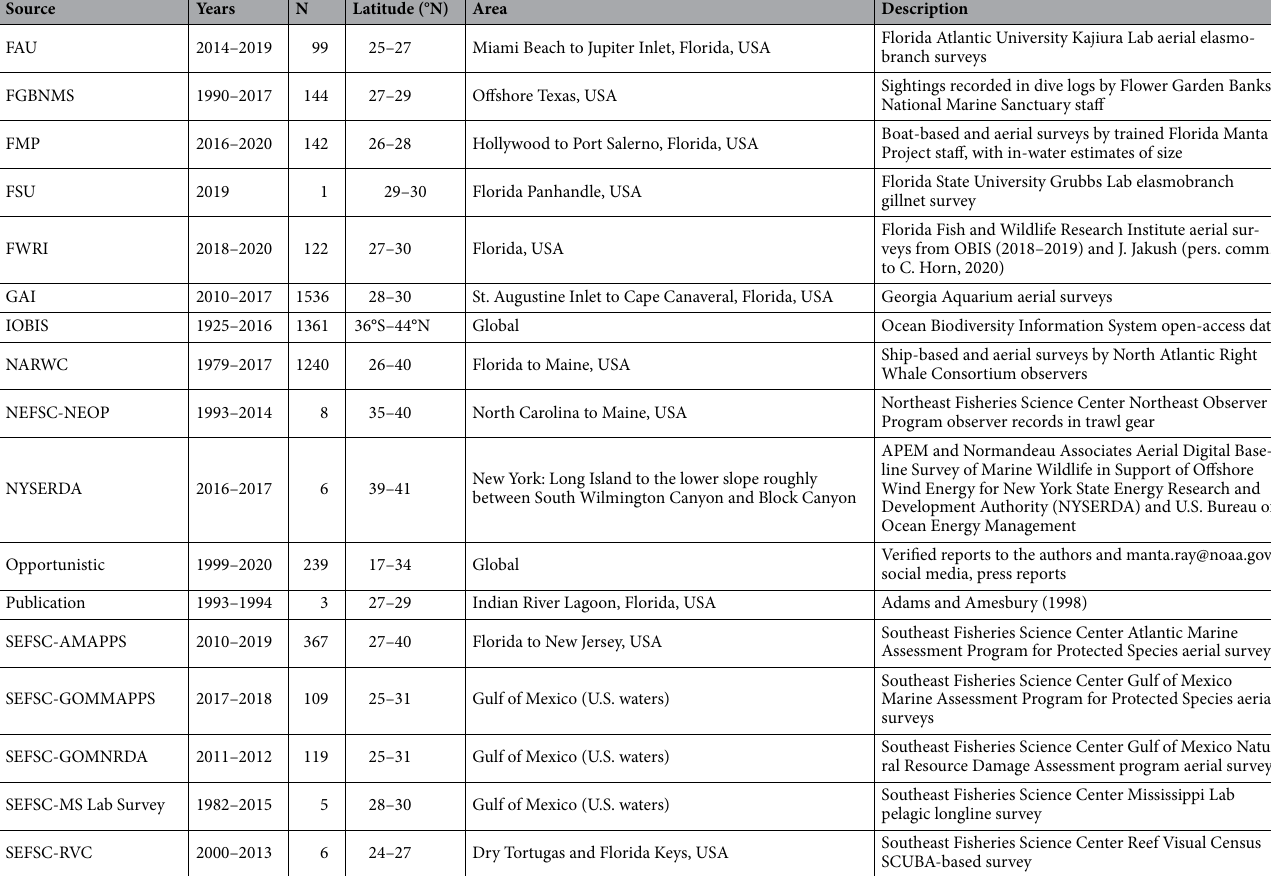
Table 1. Geographic and temporal range for data sources for manta ray sightings, with number (N)